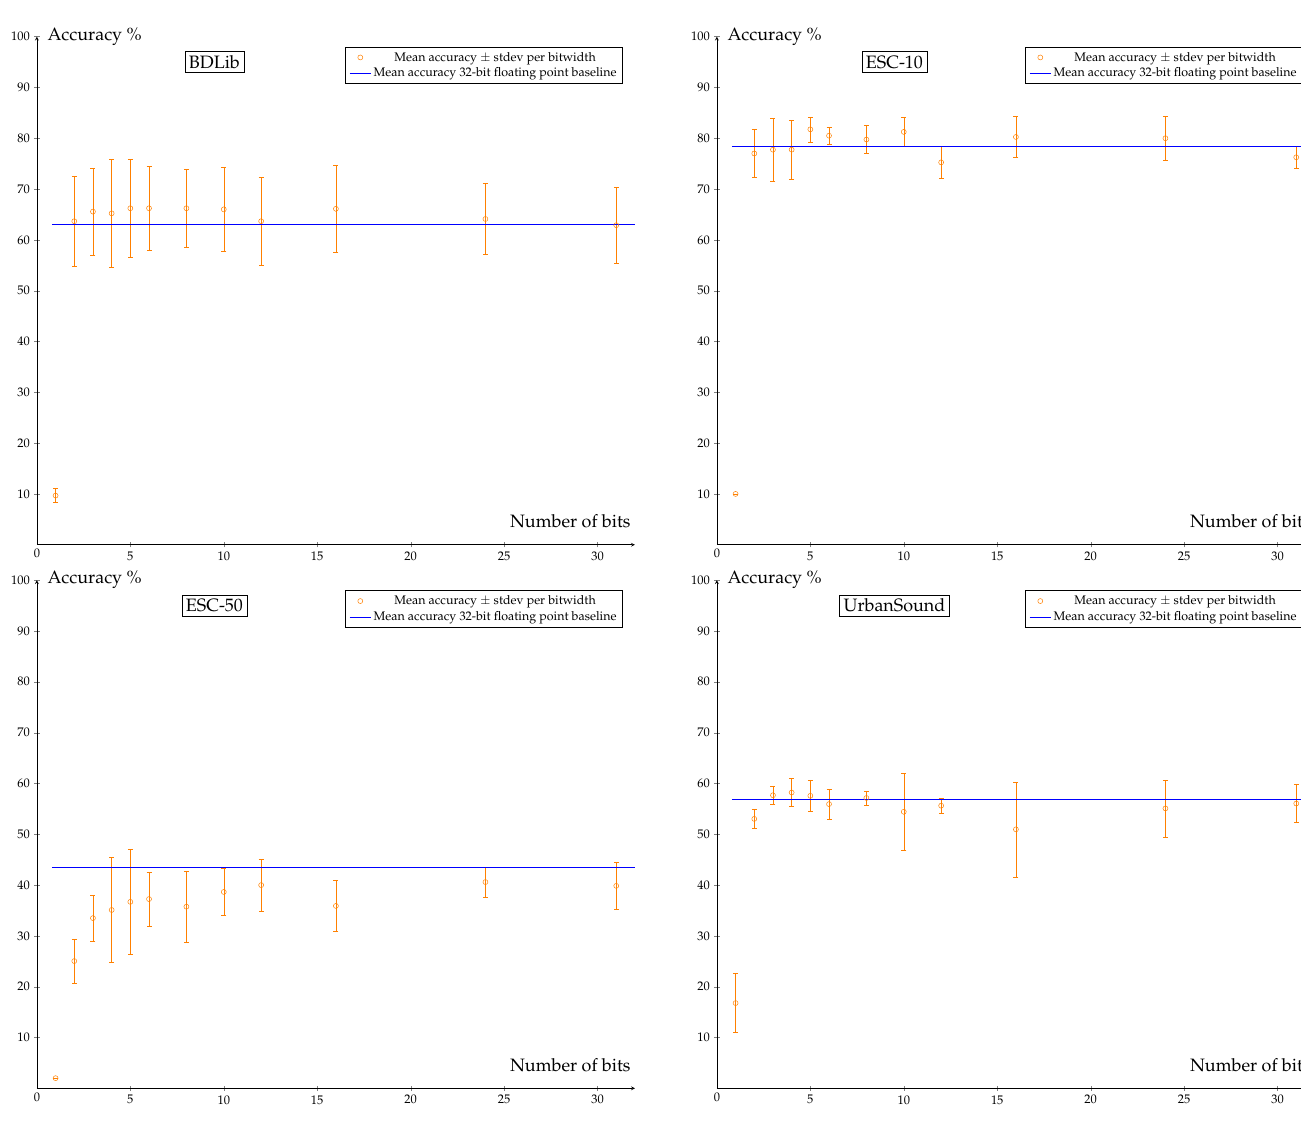
Figure 8. Accuracy of models after QAT depending on the number of bits for the model parameters after quantizing the model. The blue line represents the accuracy of the floating point model. A clear degradation in accuracy can be observed when using one bit, while using three or more bits only results in a minor loss of